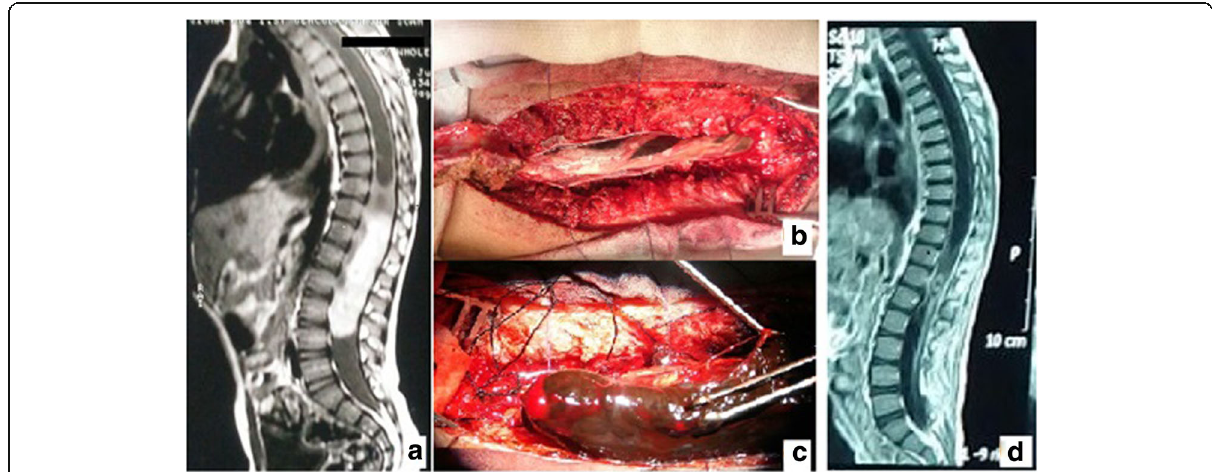
Fig. 1 a Preoperative MRI T1WI with contrast. b Intraoperative view with the lesion under the nerve roots. c During tumor removal. d Postoperative MRI T1WI with